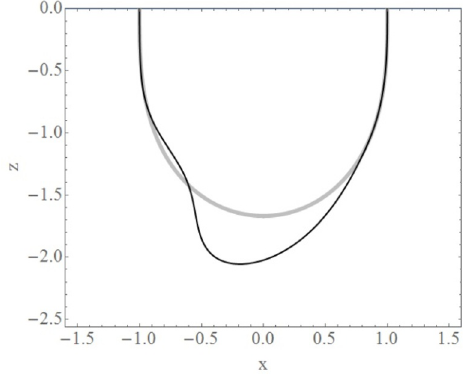
Figure 7 . Segmented string with N kink = 300 . The perturbation of the left endpoint ( ∆ t = 4 , (cid:15) = 0 . 05 ) has created a large wave on the string.